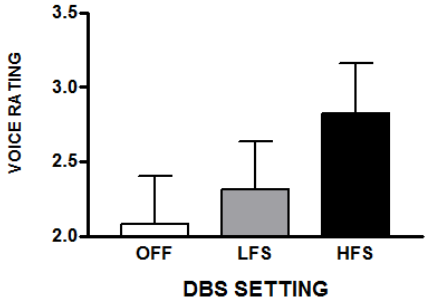
Figure 3. The average subjective ratings of voice abnormalities (with standard errors) that raters reported for a set of spontaneous speech samples obtained during the three STN-DBS conditions. These samples were not used for the transcription task but were used for the voice, articulation, fluency, and rate judgments. The scale was 1 (normal) to 5 (abnormal).